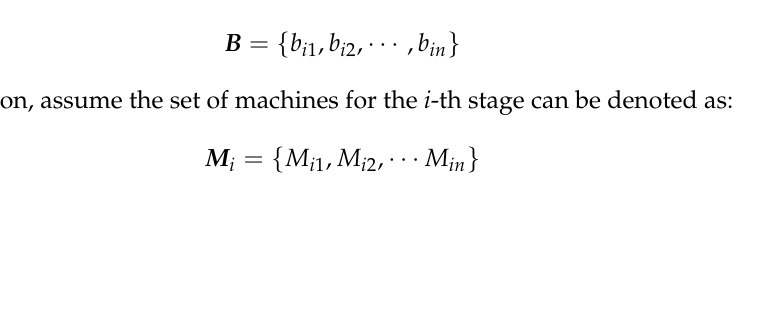
Figure 4. The six-machine-five-buffer (6M5B) tandem line.